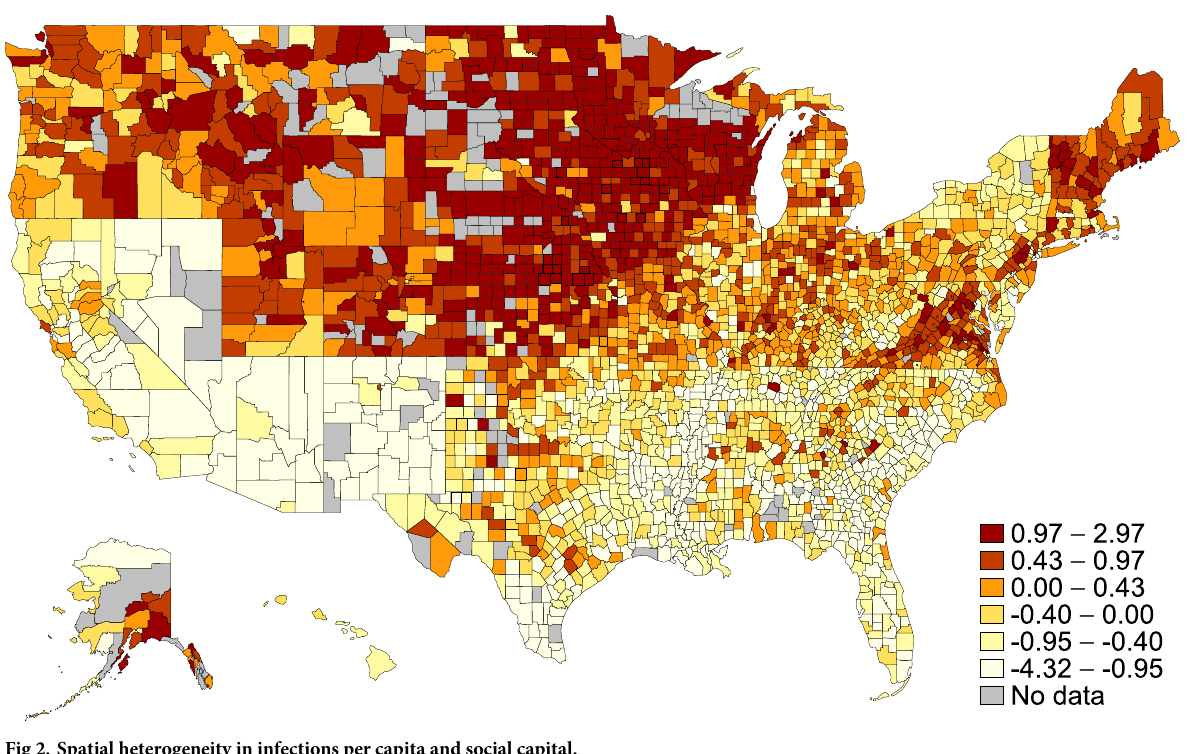
Fig 2. Spatial heterogeneity in infections per capita and social capital.